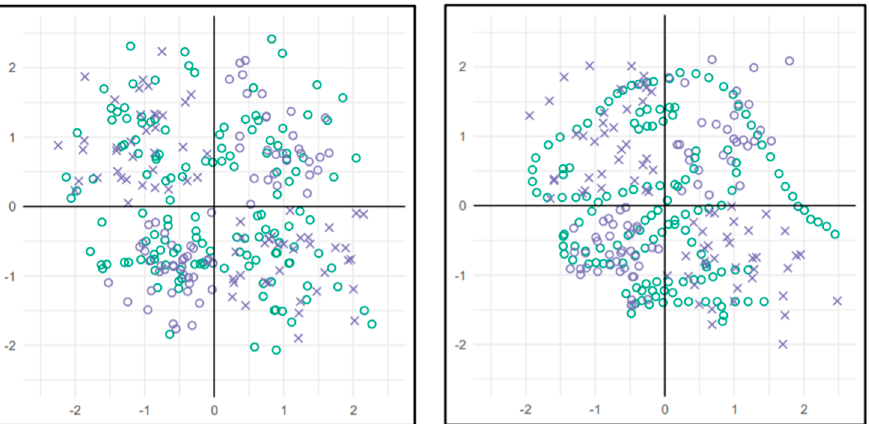
Figure 3. In Boger et al. [84], participants viewed a series of plots while they performed a task that required them to focus on one aspect of each display. In one example, participants were tasked with identifying which quadrants of the plots contained blue Xs (i.e., upper left and lower right in the left panel). In some instances, other symbols on the plot formed the contour of a dinosaur (right panel). 93% of participants failed to notice any unusual patterns in the data. When explicitly asked if they had noticed a dinosaur, they reported that they had not. From [84].